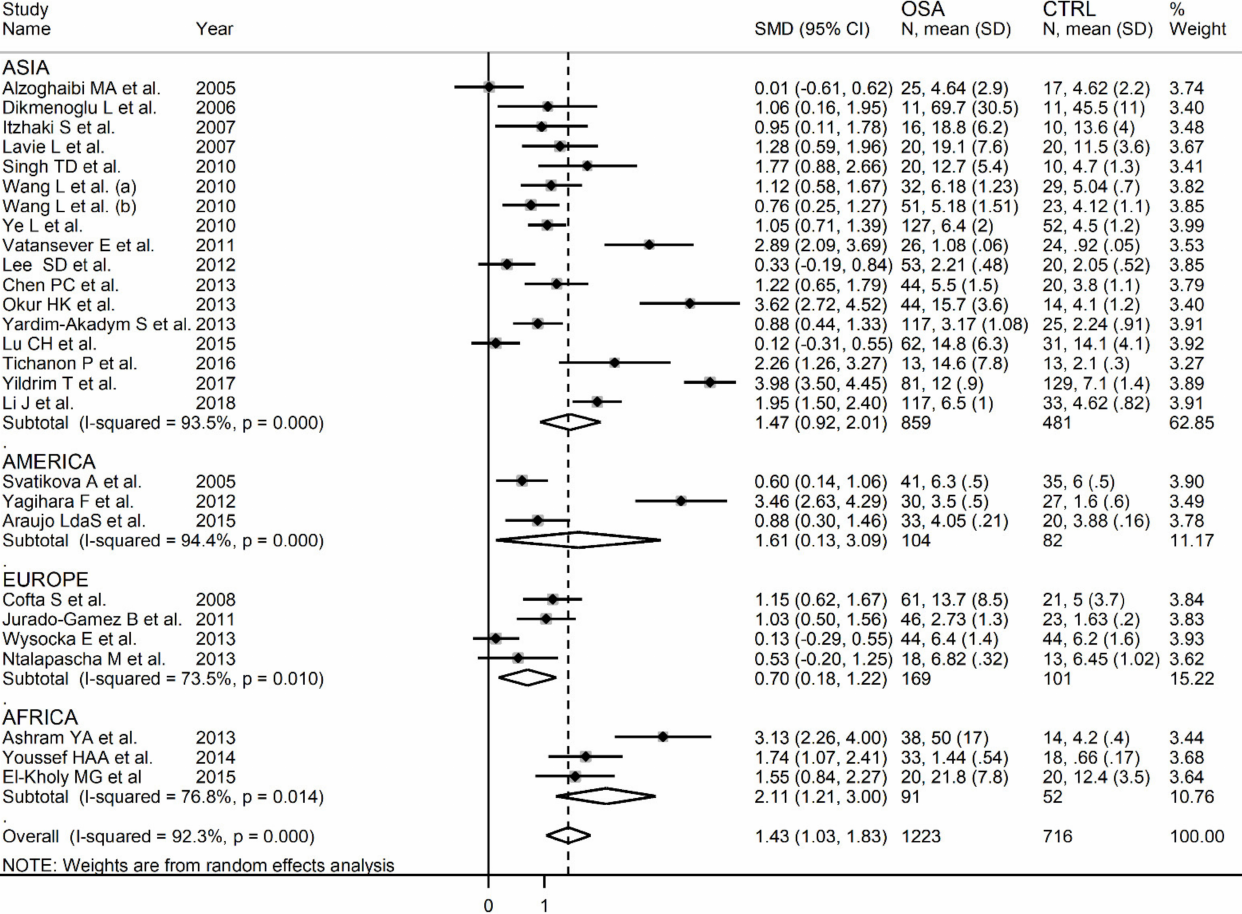
Figure 7. Forest plot of studies examining MDA concentrations in OSA and in controls according to the geographic area where the study was